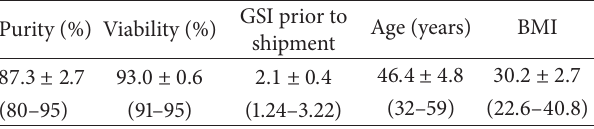
Table 1: Donor and donor islet